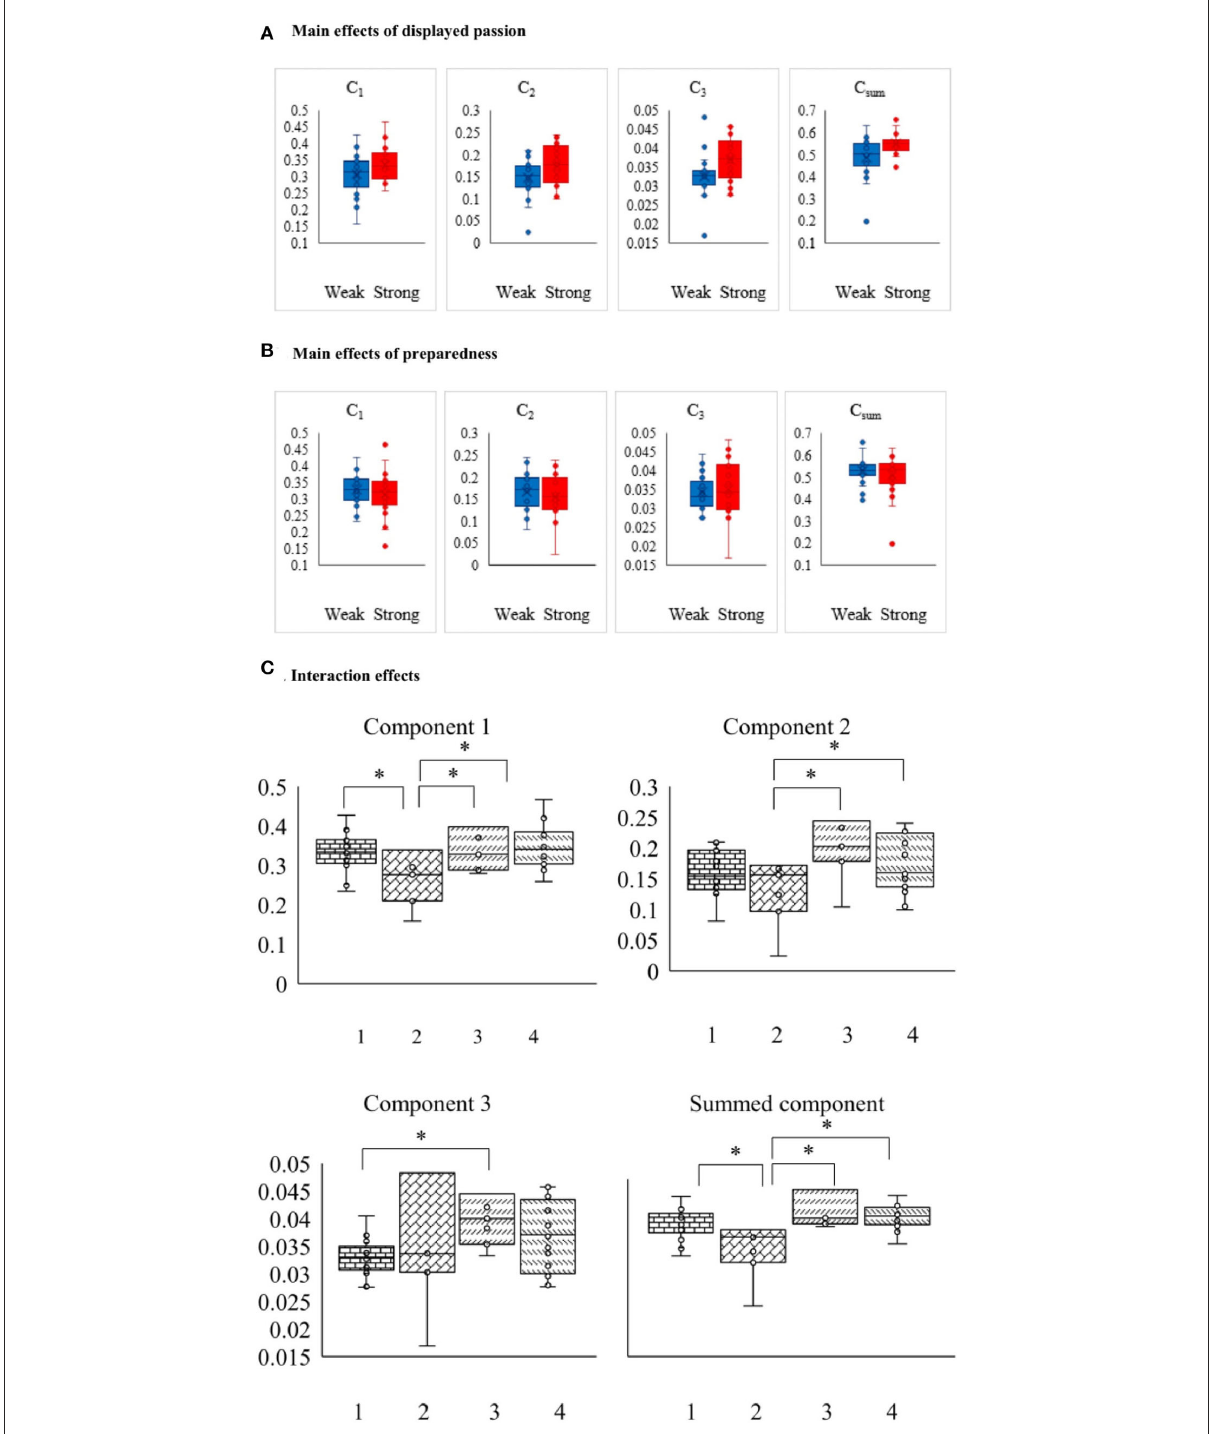
FIGURE2 EEG-ISC detects differences during the viewing of different videos. (1) Box plots a and b show average EEG-ISC for each component, separated by video categories high (red) and low (blue) passion. We use a smaller scale unit on the third component to show differences among different videos because the third one captured least ISC among all those components. (2) Box plots c show average EEG-ISC for each component, separated by video categories (1–4). Video category 1–4 represents “weak displayed passion * weak preparedness,” “weak displayed passion * strong preparedness,” “strong displayed passion * weak preparedness,” “strong displayed passion strong preparedness.” We use a smaller scale unit on the third component to show differences among different videos because the third one captured least ISC among all those